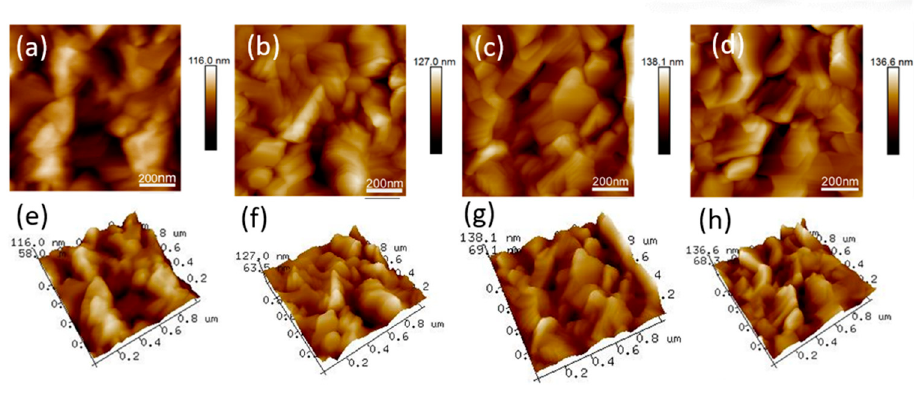
Figure 6. Atomic force microscopy (AFM) images of the perovskites film by di ff erent precursors ( a , e ) 0DMF, ( b , f ) 1DMF, ( c , g ) 2DMF, ( d , h )